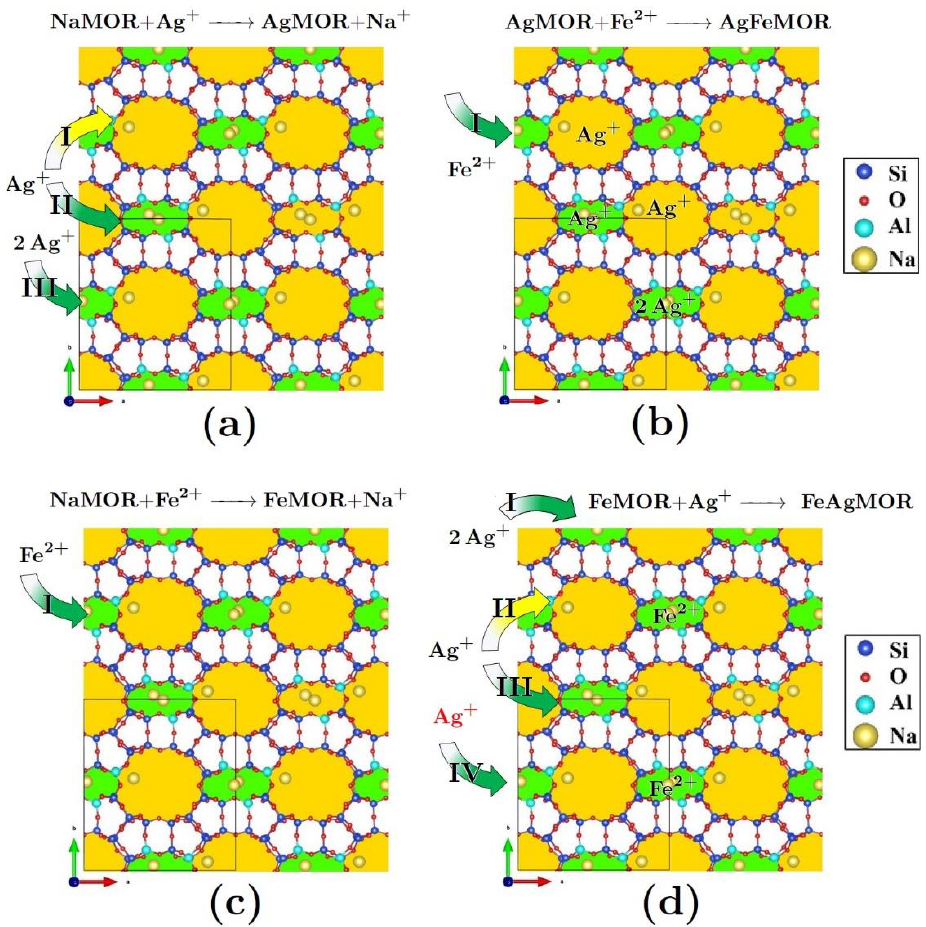
Figure 8. Sketch of distribution processes of Ag + and Fe 2+ cations in mordenite channels. Formation of ( a ) FeMOR, ( b ) FeAgMOR; ( c ) AgMOR and ( d ) AgFeMOR.